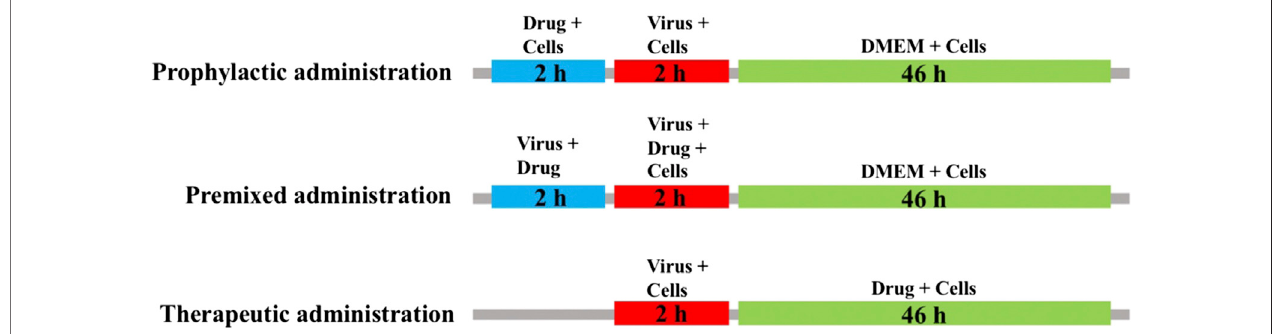
FIGURE 1 | Sketch of three medication modes. Prophylactic administration: drugs added to the cell culture 2 h before the infectious virus was added to MDCK cells. Premixedadministration:drugsand virusweremixedandincubated at 4 Cfor2 h, andthen themixturewasaddedtothecellculture andincubated at 4 Cfor2 h. Therapeutic administration: drugs were added to MDCK cells after infection by the